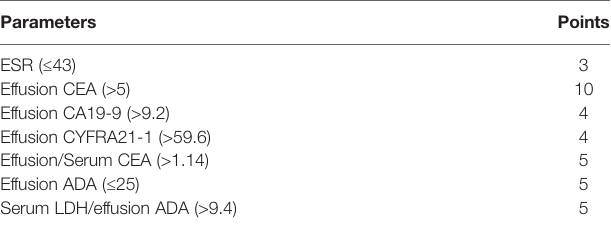
TABLE 3 | Diagnostic nomogram score calculation. Parameters